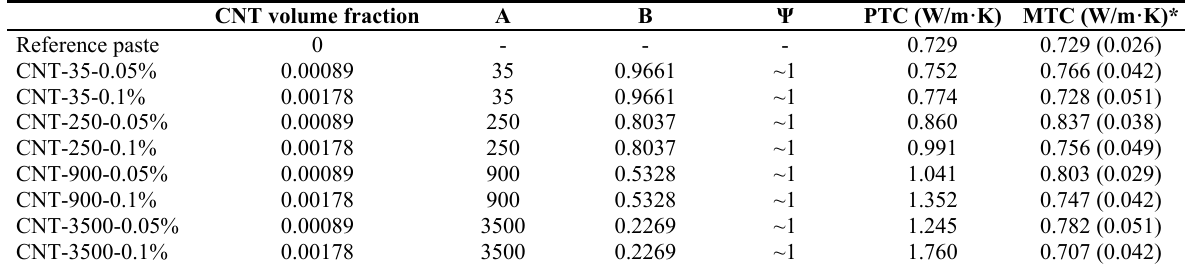
Table 2. Detailed data from the Lewis-Nielsen prediction